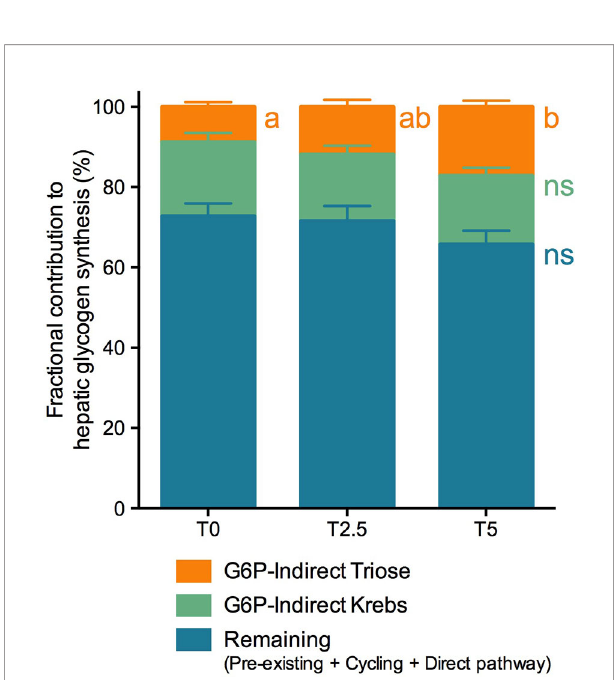
FIGURE 4 | Fractional contribution to hepatic glycogen synthesis of rainbow trout ( Oncorhynchus mykiss ) fed with different levels of glycerol (0, 2.5, and 5%) for 8 weeks. Contributions are represented as percentage of total (%). Values are mean ± SEM (n = 12). Signi fi cant differences are indicated by different letters (one-way ANOVA; followed by Tukey for p < 0.05; ns, not signi fi cant). The color scheme corresponds to metabolic pathways depicted in Figure 1